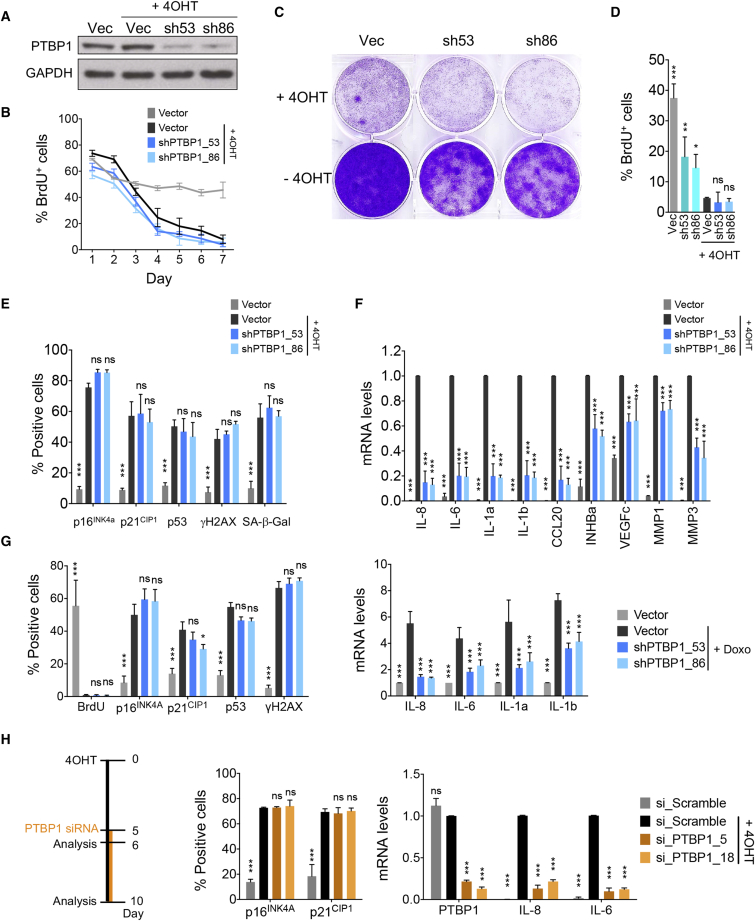
The Splicing Factor PTBP1 Regulates the SASP without Affecting Growth Arrest(A) Immunoblot of protein extracts 6 days after 4OHT induction of IMR90 ER:RAS cells infected with indicated pGIPz shRNA vectors targeting PTBP1. Vec, empty vector.(B) Quantification of cells positive for BrdU incorporation at indicated days after 4OHT treatment. Data represent mean ± SD (n = 3).(C) Crystal violet-stained 6-well dishes of cells fixed 12 days following 4OHT treatment.(D) Quantification of BrdU incorporation 8 days after 4OHT treatment, 15 days after empty vector or PTBP1 shRNA infection. Data represent mean ± SD (n = 3); ∗p < 0.05, ∗∗p < 0.01, ∗∗∗p < 0.001; ns, not significant. Comparisons with Vec + 4OHT. One-way ANOVA (Dunnett's test).(E) Quantification of cells positive for the senescence markers p16, p21, p53, and γH2AX 6 days after 4OHT and β-galactosidase 8 days after 4OHT by IF analysis. Data represent mean ± SD (n = 3). ∗∗∗p < 0.001; ns, not significant. Comparisons with Vector + 4OHT, two-way ANOVA (Bonferroni’s test).(F) Expression levels of the indicated SASP genes assessed by qRT-PCR 6 days after 4OHT induction normalized and compared with Vector + 4OHT. Data represent mean ± SD (n = 3); ∗∗∗p < 0.001, two-way ANOVA (Dunnett's test).(G) IMR90 WT cells were infected with indicated pGIPZ empty vector or PTBP1 shRNAs and treated with doxorubicin to induce senescence. Left: IF analysis of the indicated senescence markers 6 days after doxorubicin induction. Right: mRNA analysis of the indicated genes by qRT-PCR (right) 8 days after doxorubicin induction normalized to the Vector + doxycycline (Doxo) condition. Data represent mean ± SD (n = 3). ∗p < 0.05, ∗∗∗p < 0.001; ns, not significant. Comparisons with Vector + Doxo, two-way ANOVA (Dunnett's test).(H) IMR90 ER:RAS cells were transfected with two independent siRNAs targeting PTBP1 at day 5 after senescence induction as indicated in the scheme (left). Senescence establishment at day 6 was monitored by IF analysis (middle). Knockdown of PTBP1 and the effect on the indicated genes was assessed by qRT-PCR 5 days after siRNA transfection, and 10 days after senescence induction (right), normalized to the si_Scramble + 4OHT condition. Data represent mean ± SD (n = 3). ∗∗∗p < 0.001; ns, not significant. Comparisons with si_Scramble + 4OHT, two-way ANOVA (Dunnett's test).See also Figure S3.